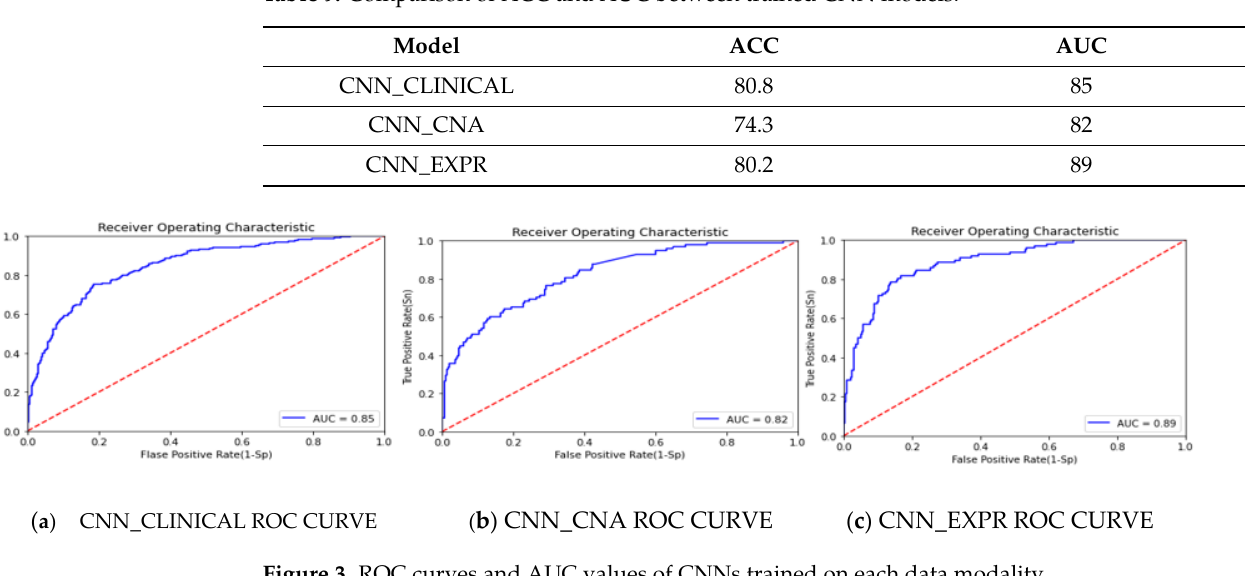
Table 10. The performance of CNN_GRU, CNN_LSTM, and VOTING models with stacked features.